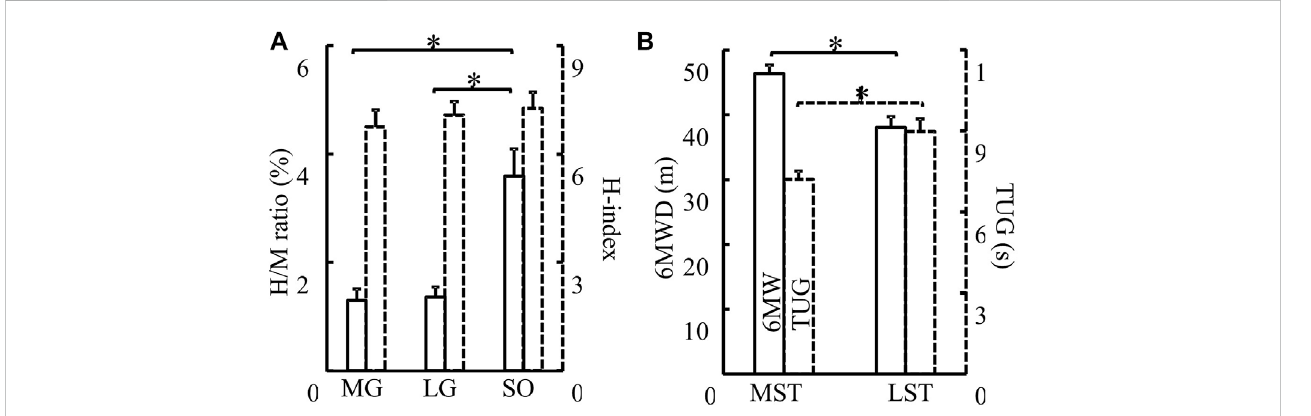
FIGURE 2 (A) H/M ratio (solid) and H-index (dashed) of the MG, LG, and SO muscles were compared. There were no differences between groups in H/M ratio and H-index ( p > .05). H/M ratio of SO was signi fi cantly greater than that of both MG ( p < .001, d = .232) and LG ( p < .001, d = .098). No difference in H-index was detected among different muscles (B) MST and LST groups were compared for both 6MWD (solid, p = .006, partial η 2 = .318) and TUG (dash, p = .011, partial η 2 =.282).The MSTgroup walkedfarther (6MWD) and fast(TUG) than theLSTgroup. *Indicates asigni fi cant difference between muscles (left)orgroups (right).